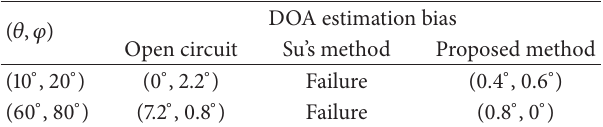
Table 5: Two-dimensional DOA estimation bias for the